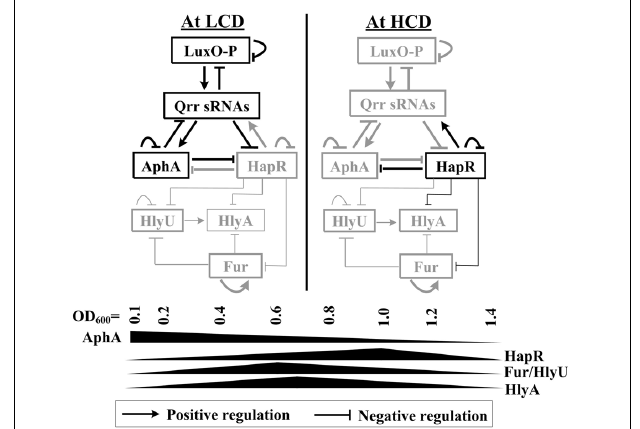
FIGURE 8 | Regulatory circuit. The regulatory actions between LuxO, Qrr sRNAs, AphA, and HapR were previously described in Vibrio cholerae and closely related vibrios (Henke and Bassler, 2004; Tu et al., 2010; Rutherford et al., 2011; Sun et al., 2012; Zhang et al., 2012). AphA and HapR are the two master QS regulators operating at LCD and HCD, respectively. Fur and HlyU, which are transcribed highly at an OD 600 value of around 0.6, coordinate with HapR to tightly regulate hlyA transcription, leading to the high expression of HlyA at the early mid-logarithmic growth phase. Positive autoregulation of Fur has been established in V. vulnificus (Lee et al., 2007); this mechanism would be conserved between V. vulnificus and Vibrio cholerae